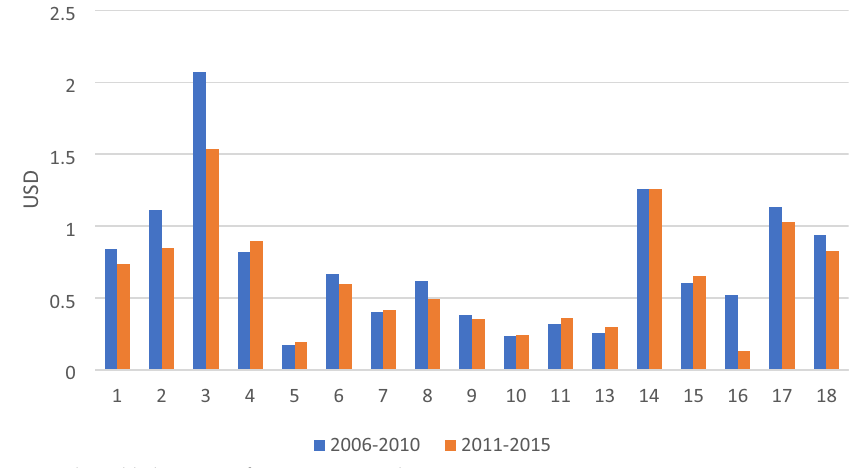
Fig. 4 Value-added intensity of Vietnam’s exports by sector